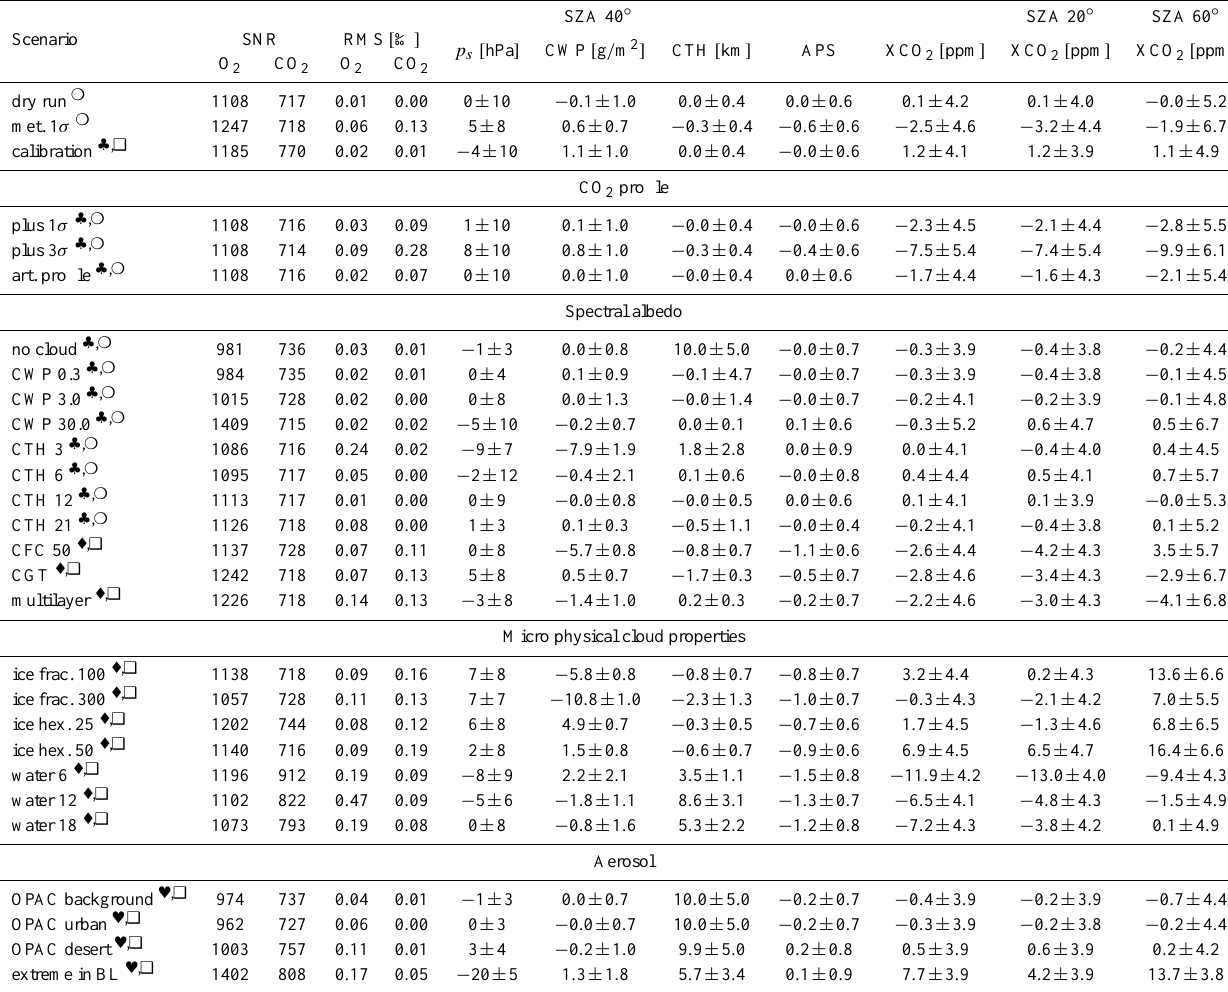
Table A1. As Table 2 but with an spectrally constant albedo of 0 .